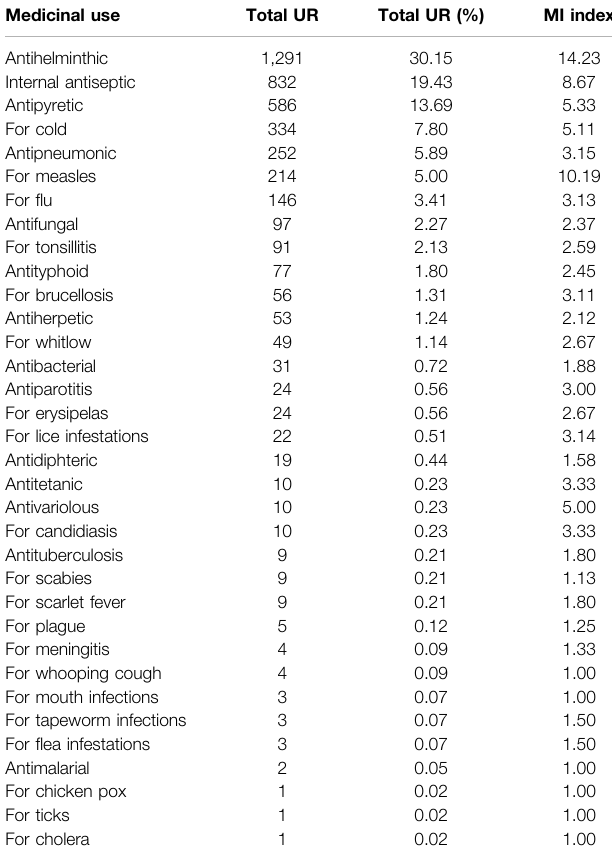
TABLE 2 | Medicinal uses to treat infections and infestations and values of total use reports, total usereportspercentage and medicinal importance (MI) index in the studied